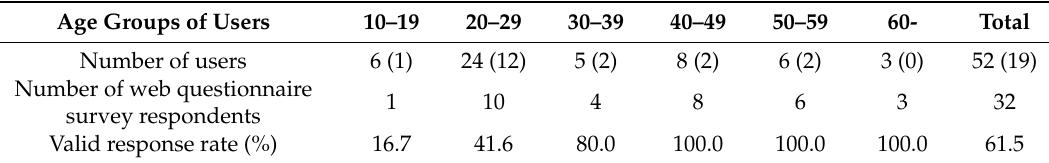
Table 1. Breakdown of system users and web questionnaire survey